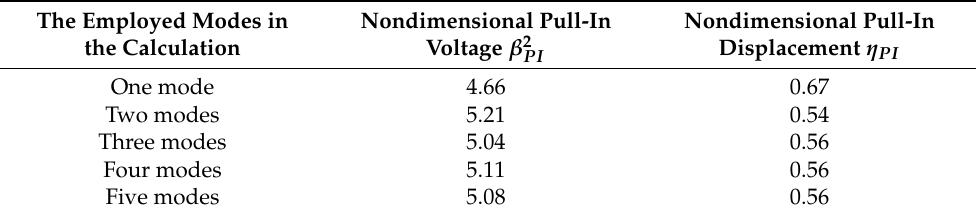
Figure 4. The variation of nondimensional tip deflection with nondimensional voltage for suspended microchannel resonators at different ˆ U . Table 2. The nondimensional pull-in voltage and displacement of the suspended microchannel resonator for different modes employed in the calculation at ˆ U =